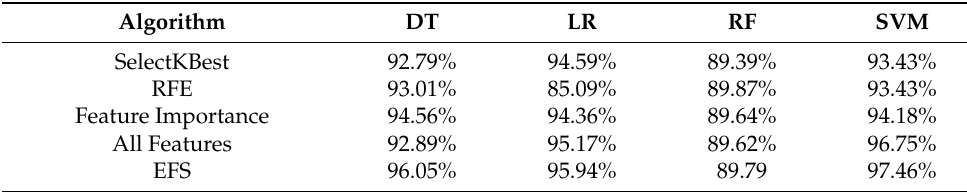
Table 6. Accuracy results using different subsets of features.